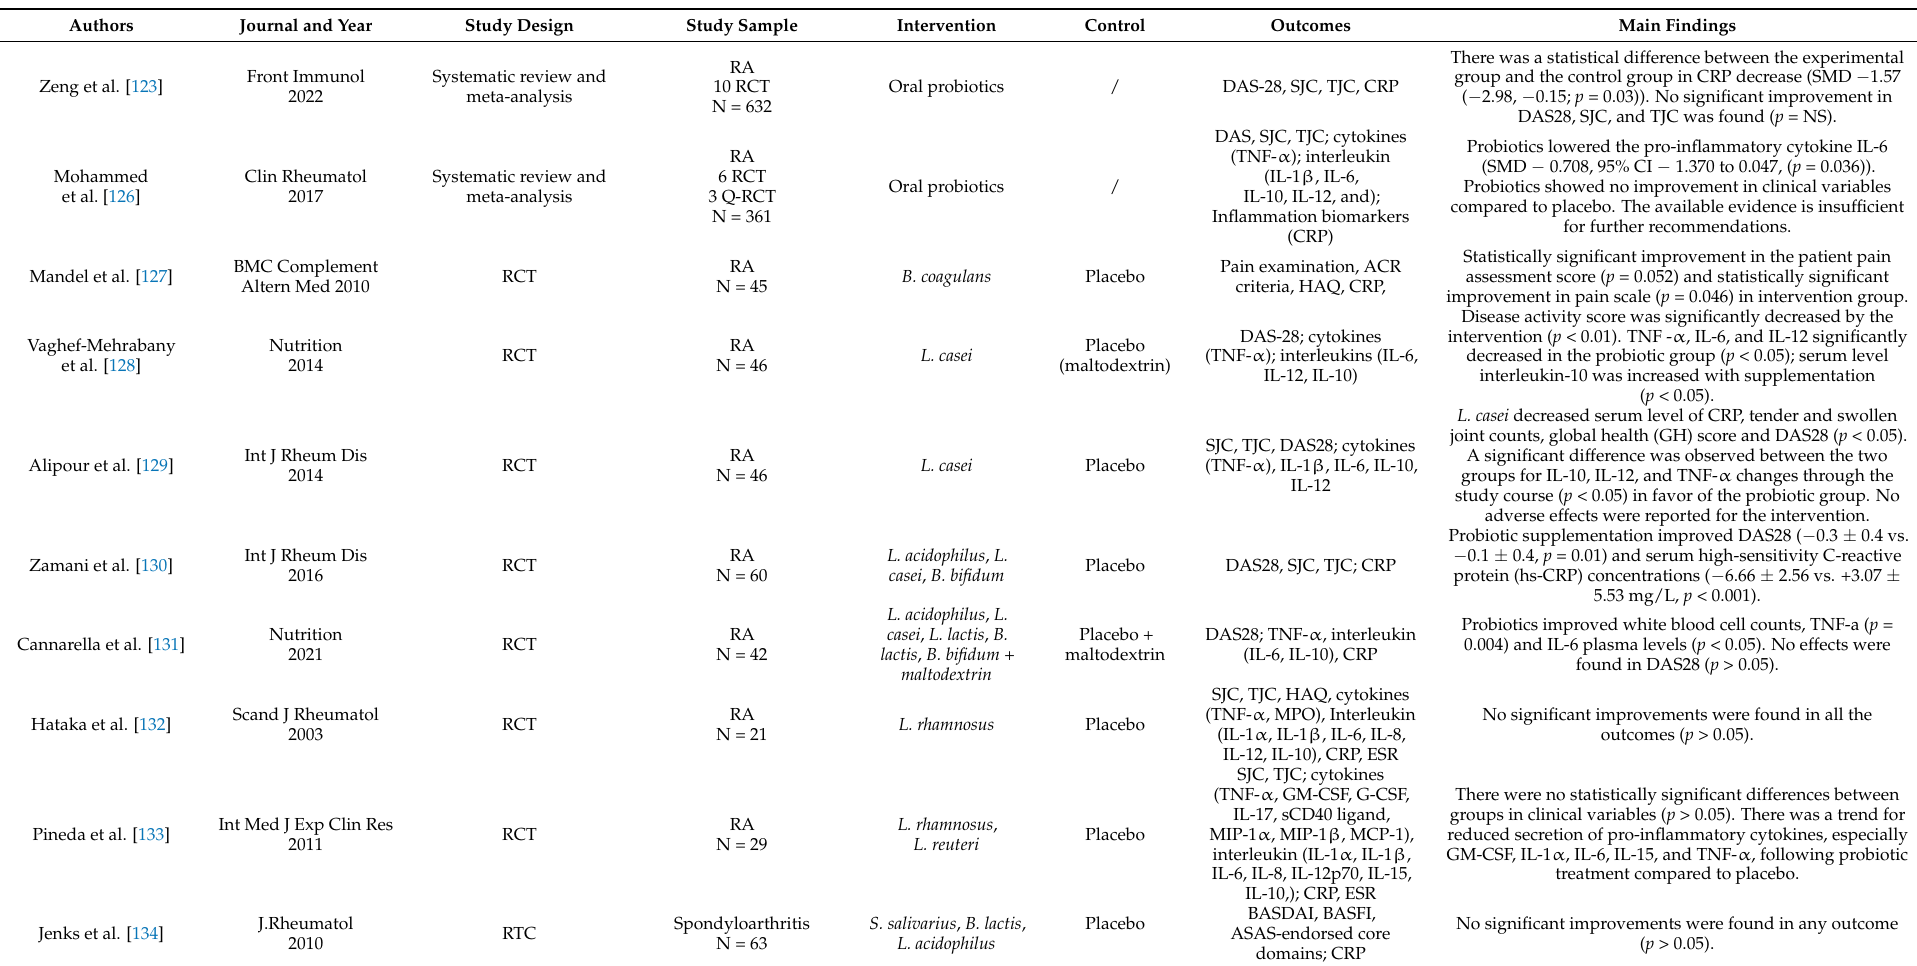
Table 2. Probiotics for musculoskeletal disorders in human